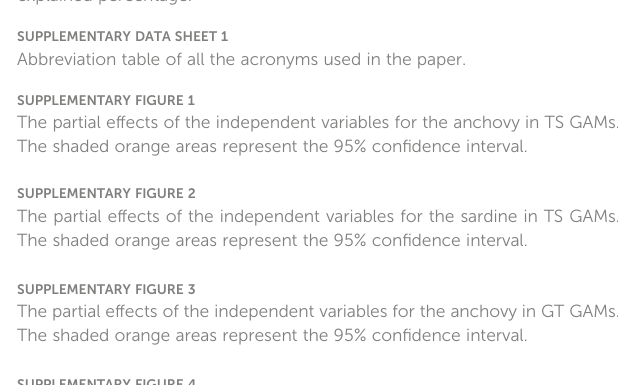
SUPPLEMENTARY DATA SHEET 1 Abbreviation table of all the acronyms used in the paper. SUPPLEMENTARY FIGURE 1 The partial effects of the independent variables for the anchovy in TS GAMs. The shaded orange areas represent the 95% con fi dence interval. SUPPLEMENTARY FIGURE 2 The partial effects of the independent variables for the sardine in TS GAMs. The shaded orange areas represent the 95% con fi dence interval. SUPPLEMENTARY FIGURE 3 The partial effects of the independent variables for the anchovy in GT GAMs. The shaded orange areas represent the 95% con fi dence interval. SUPPLEMENTARY FIGURE 4 The partial effects of the independent variables for the sardine in GT GAMs. The shaded orange areas represent the 95% con fi dence interval. SUPPLEMENTARY FIGURE 5 Scatterplots of the predicted vs observed biomass values in tonnes retrieved from the Random Forest regression models. (A) Anchovy in TS, (B) Sardine in TS, (C) Anchovy in GT, (D) Sardine in GT. The black line represents the 1:1 line. SUPPLEMENTARY FIGURE 6 The ROC plots for the classi fi cation models. They are divided by species and by